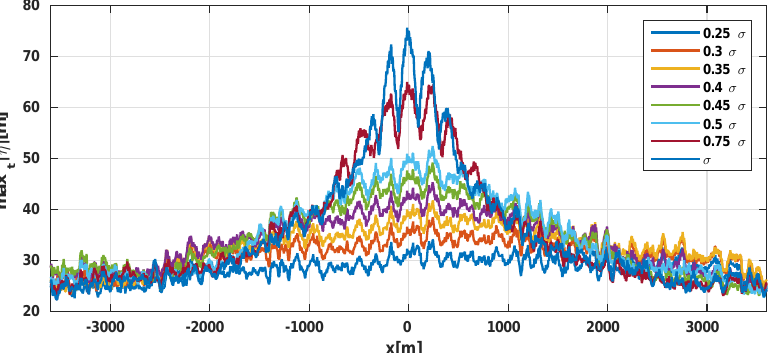
Figure 4. The maximal temporal amplitude of the linear evolution of the wpm signal with α = 0.5 for various fractions of the standard deviation σ ω